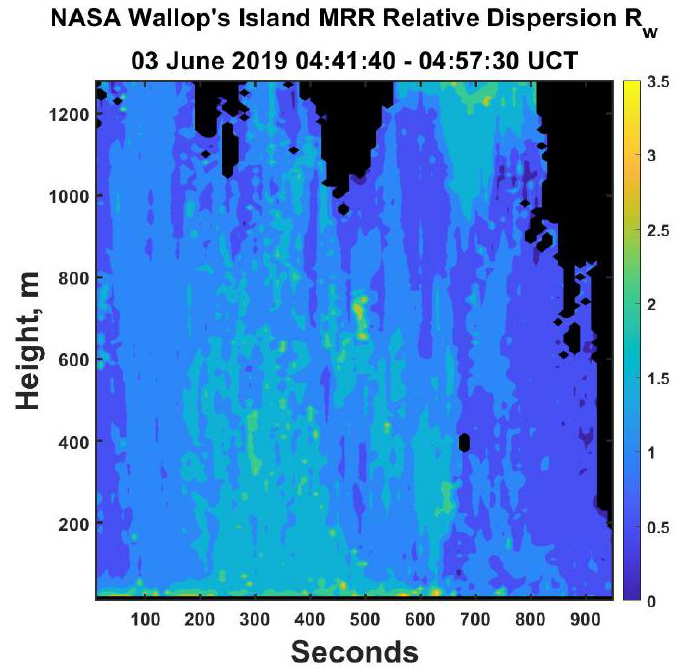
Figure 16. The time–height plot of the relative dispersion = σ Rw / R w corresponding to Figure 15b. Note that in contrast to Figure 8 for the later period, in this instance there are many locations where the relative dispersion is 2 or greater.